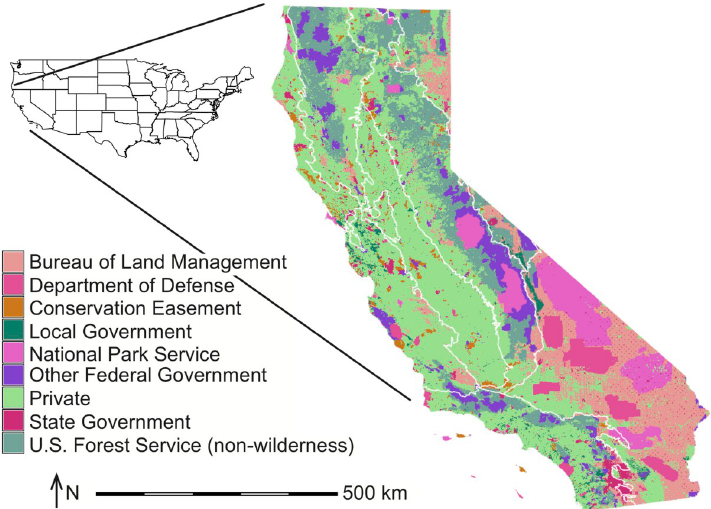
Fig 1. CALAND region (white lines) and ownership (shading) boundaries for California. This map was made using GRASS GIS 7.4.1.